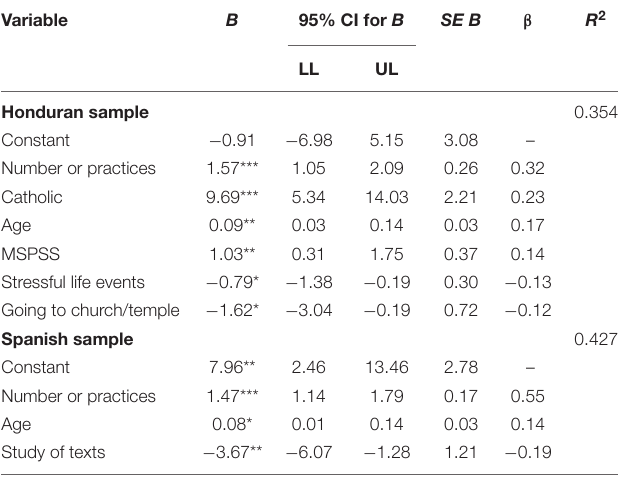
TABLE 5 | SBS-12 regression models, by